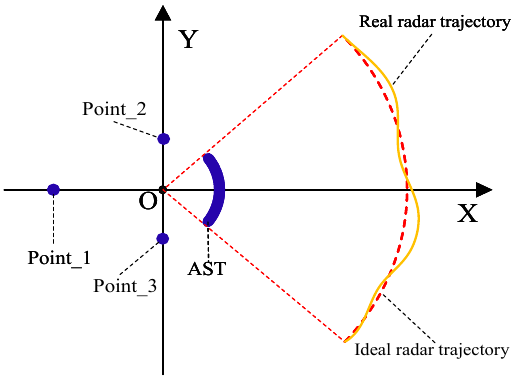
Figure 9. The illuminated scene contains an arc target and three point